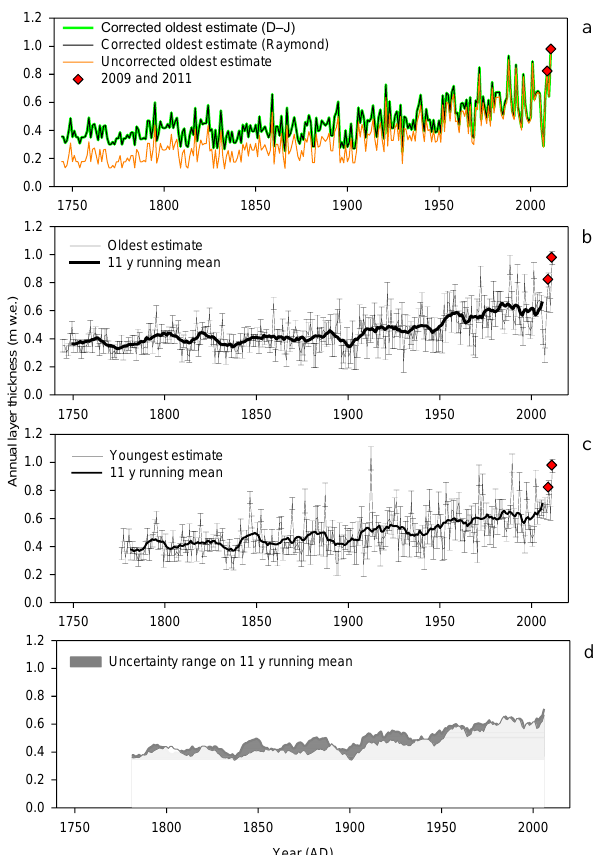
Figure 6. Annual layer thicknesses at IC12 in mw.e. (a) For the oldest estimate: uncorrected annual layer thickness (orange line), corrected annual layer thickness using the full Stokes (Drews et al., 2015) model (black line), and corrected annual layer thickness with the modified Dansgaard–Johnsen model (green line, undistin- guishable from the black line at this scale); (b) corrected annual layer thickness using Drews et al. (2015) model with error bars, showing 5–10cm depth uncertainty (thin black line) and 11year running mean (thick black line) for the oldest estimate; (c) same as (b) but for the youngest estimate; (d) range of uncertainty be- tween youngest and oldest estimates (11year running mean). Red diamonds highlight years 2009 and 2011, discussed in the